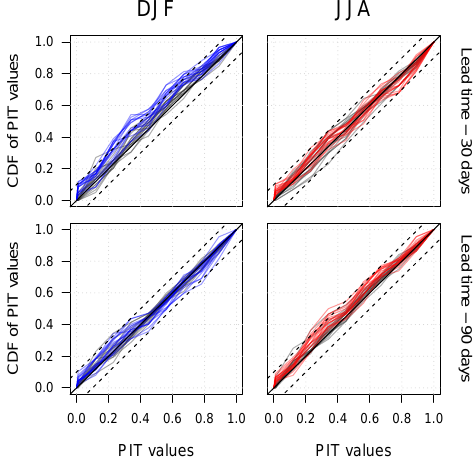
Figure 10. PIT diagram of precipitation forecasts corrected with EDMD-m (coloured lines) and historical precipitation (grey lines) for lead times of 30 days (top) and 90 days (bottom). Each column corresponds to a target season. Each line represents the PIT diagram in a catchment for forecast horizons within the target season. Dotted lines represent the ± 0.1 tolerance bands from the